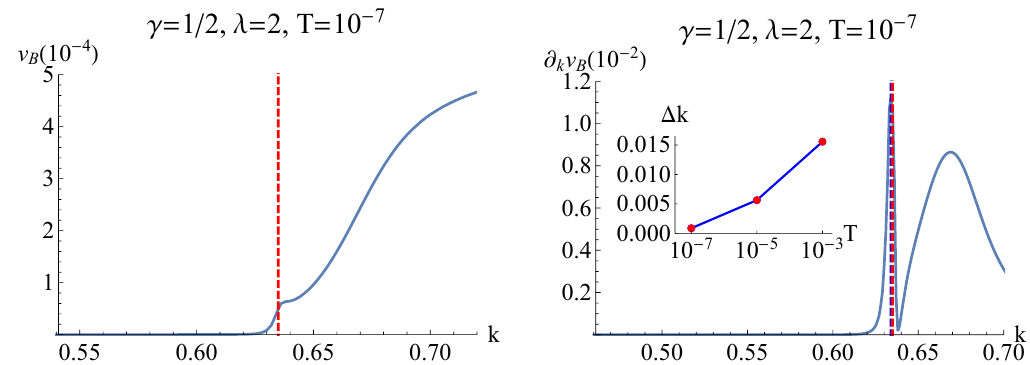
. The red dashed k v B . Here we k v B